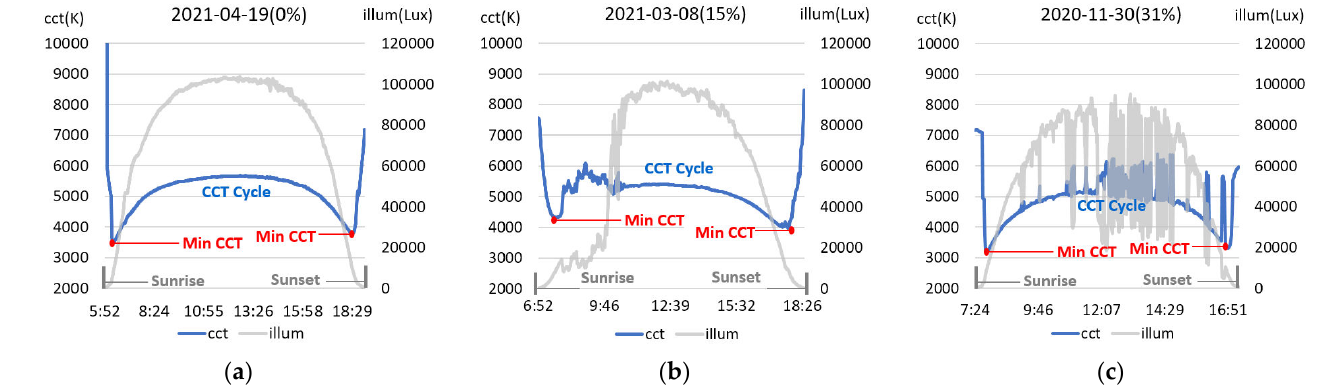
Figure 2. Example of daily color temperature cycle of natural light. ( a ) ‘21.04.19. (Anomaly ratio:0%); ( b ) ‘21.03.08. (Anomaly ratio:15%); ( c ) ‘20.11.30. (Anomaly ratio:31%).